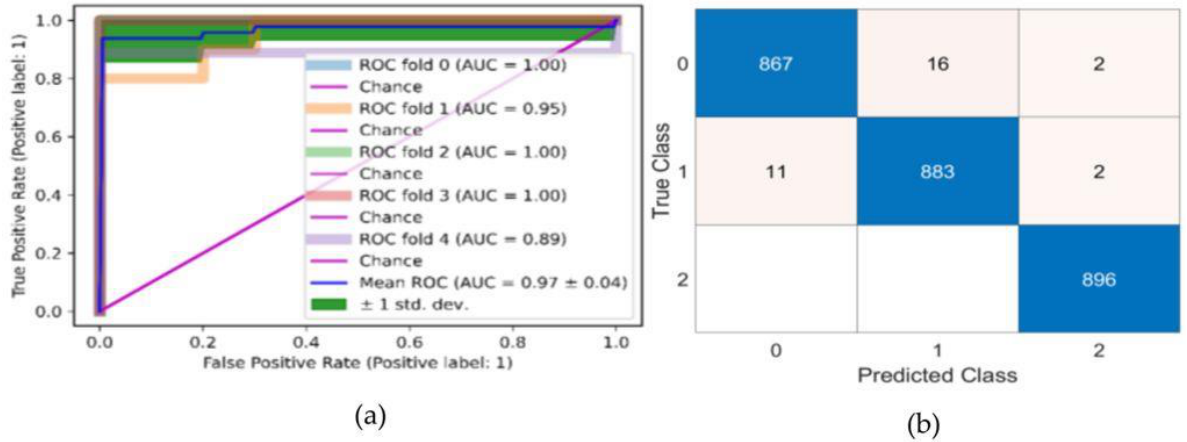
Figure 9. Classification results on PH2 ( a ) ROC curve of fine KNN ( b ) confusion matrix of fine KNN. Table 10. Proposed classification model results on HAM10000.